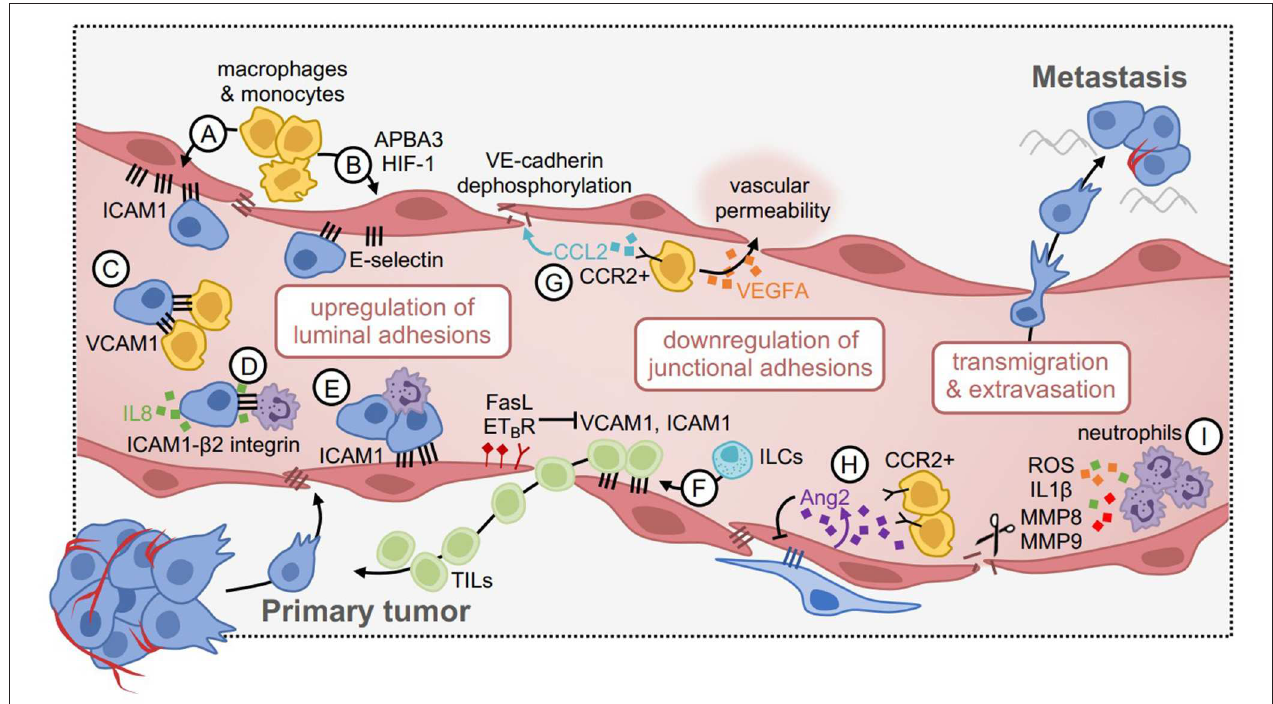
FIGURE 2 | Vascular inflammation during tumor cell extravasation and metastasis. (A) Inflammatory macrophages and monocytes induce the expression of ICAM1 and (B) E-selectin via APBA3-HIF1 signaling in endothelial cells. This enhances tumor cell attachment. (C) Tumor cells mimic the endothelium by upregulating VCAM1, which tethers them to β 1 integrin-expressing macrophages and enhances metastatic seeding. (D) Similarly, tumor cells can upregulate ICAM1, and tethers to β 2-integrin expressing neutrophils. This interaction is mediated by IL8 produced by tumor cells, which promotes neutrophil recruitment. (E) Neutrophil-tumor cell clusters enhance attachment to the endothelium via ICAM1 under flow conditions. (F) Some positive effects of vascular inflammation include enhanced recruitment of tumor-infiltrating lymphocytes (TILs), through upregulation of VCAM1 and ICAM1. This pathway can be negatively regulated, for example via FasL and ET B R, such that blocking these factors can improve TIL delivery to tumors. (G) CCR2 + monocytes are attracted to the metastatic niche in response to CCL2 expressed by tumor cells, where they produce VEGFA to increase vascular permeability. CCL2 can also act directly on the endothelium by dephosphorylating VE-cadherin, disrupting junctional integrity, and increasing tumor cell transmigration. (H) Angiopoietin 2 (Ang2) expression by endothelial cells reduces pericyte coverage and promotes the recruitment of CCR2 + monocytes, which promote permeability. (I) Neutrophils produce proteolytic and inflammatory factors (e.g., ROS, IL1 β , MMP8, MMP9) to disrupt endothelial junctions and increase vascular permeability in cancer